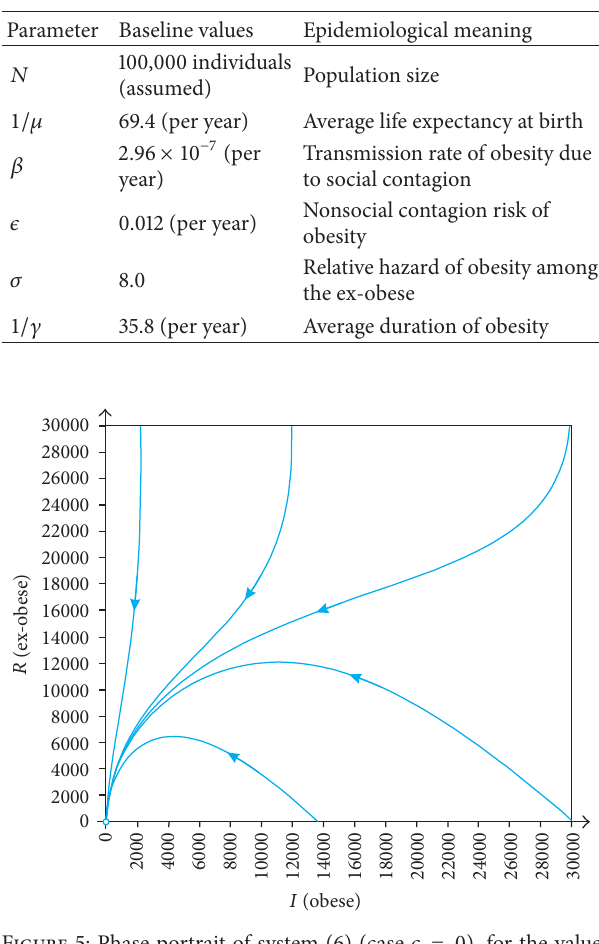
Table 1: Baseline values and epidemiological meanings of the parameters given by Ejima et al. [8].